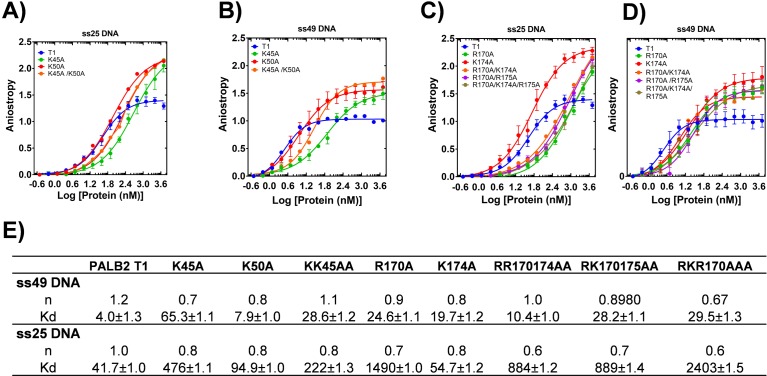
DNA binding of T1 mutants.Equilibrium binding of 5 nm FAM-ss25 (A, C) or FAM-ss49 (B, D) to PALB2 N-DBD and its mutants. (blue) In A) and B) isotherm for K45A is in green, for K50A in red, for K45A/K50A in black. In C) and D) isotherm for R170A is in red, for K174A in green, for R170A/K174A in magenta, for R170A/R175A in orange, and for R170A/K174A/R175A in black. The binding buffer is 20 mM Tris-acetate pH 7.0, 100 mM NaCl, 5% glycerol, 10% DMSO.